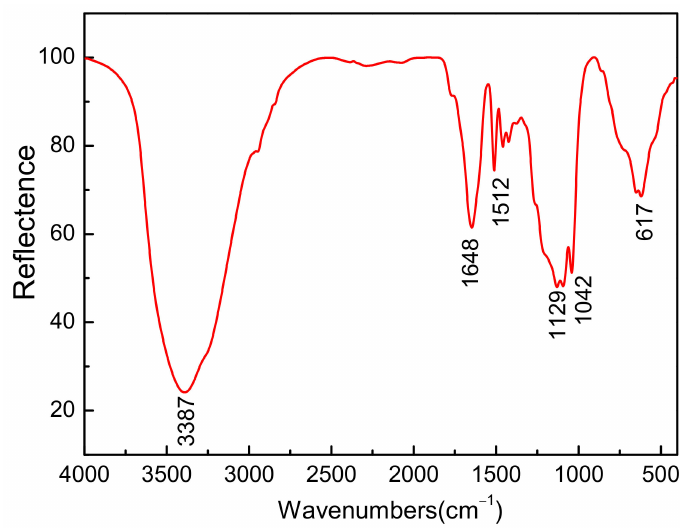
Figure 10. FTIR spectrum of CLS.